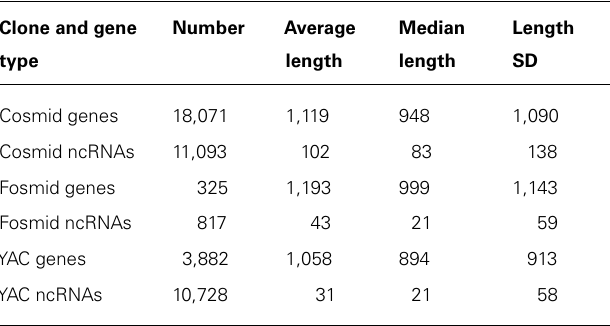
Table 2 | Number and length statistics of protein-coding genes and ncRNAs in cosmids, fosmids and exclusive toYACs. Clone and gene